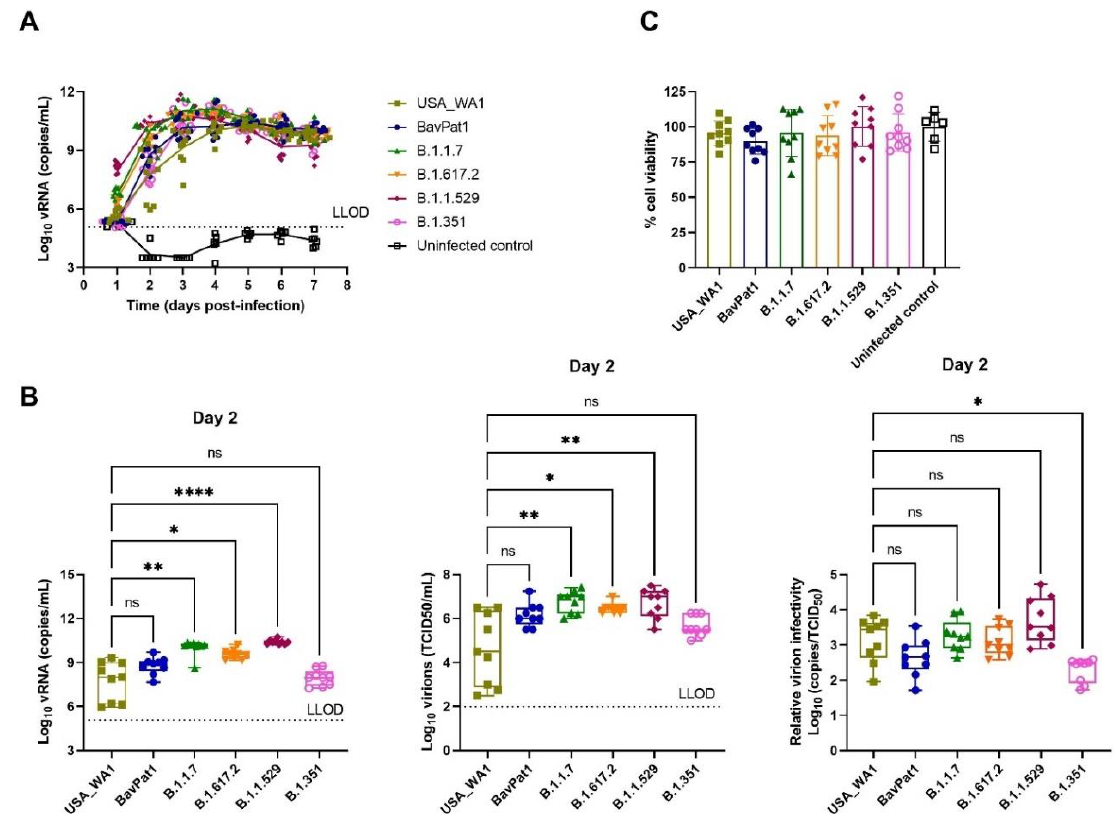
Figure 5. The replication profile of different SARS-CoV-2 isolates in nasal HAEC. The nasal tissues were infected with SARS-CoV-2 at 2 × 10 3 TCID 50 /culture at 35 °C for 7 days. ( A ) Viral loads from the apical washes are expressed as log 10 SARS-CoV-2 RNA copies per mL. ( B ) Viral RNA copies, infectious particles, and relative virion infectivity at 2 d.p.i. are expressed as log 10 RNA copies per mL, log 10 TCID50 per mL, and log 10 inverse ratio of TCID50-per-copy, respectively. ( C ) Cell viability of HnAEC after 7 days p.i. Each dot represents individual data. The lower limit of detection (LLOD) is indicated as dotted lines. Statistical significance was determined using Kruskal – Wallis with Dun-